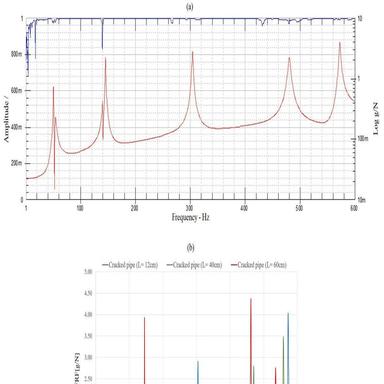
Healthy pipe FRF measurements and coherence (a) and cracked pipe using different crack lengths (12 cm, 40 cm, and 60 cm) (b).